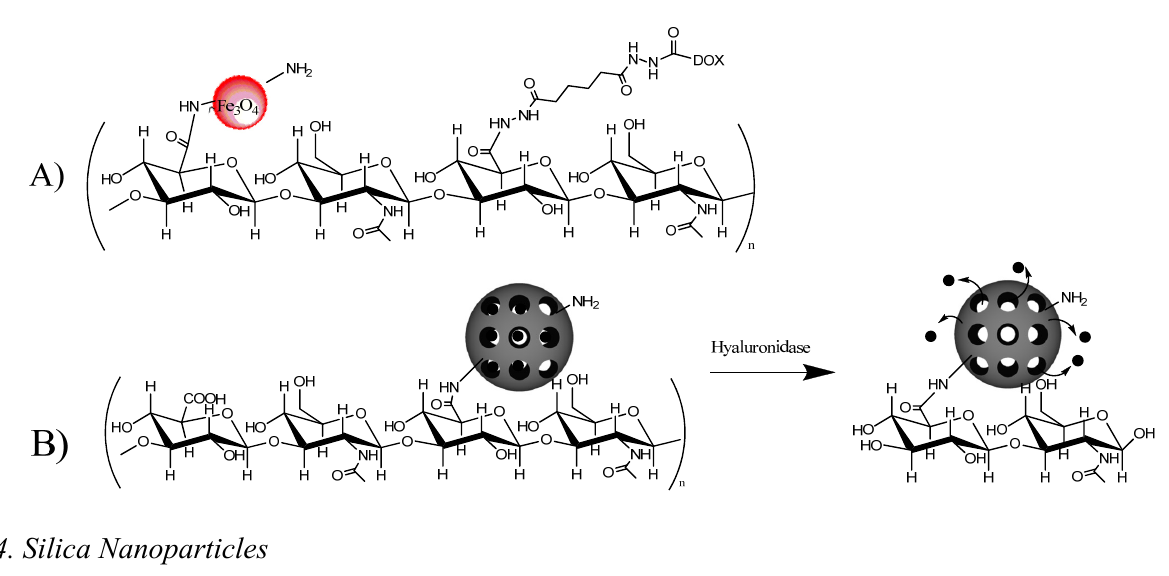
Figure 5. SPION (or SNP) loading HA-linked DOX ( A ); MSP and drug release after treatment with Hyaluronidase-1 ( B